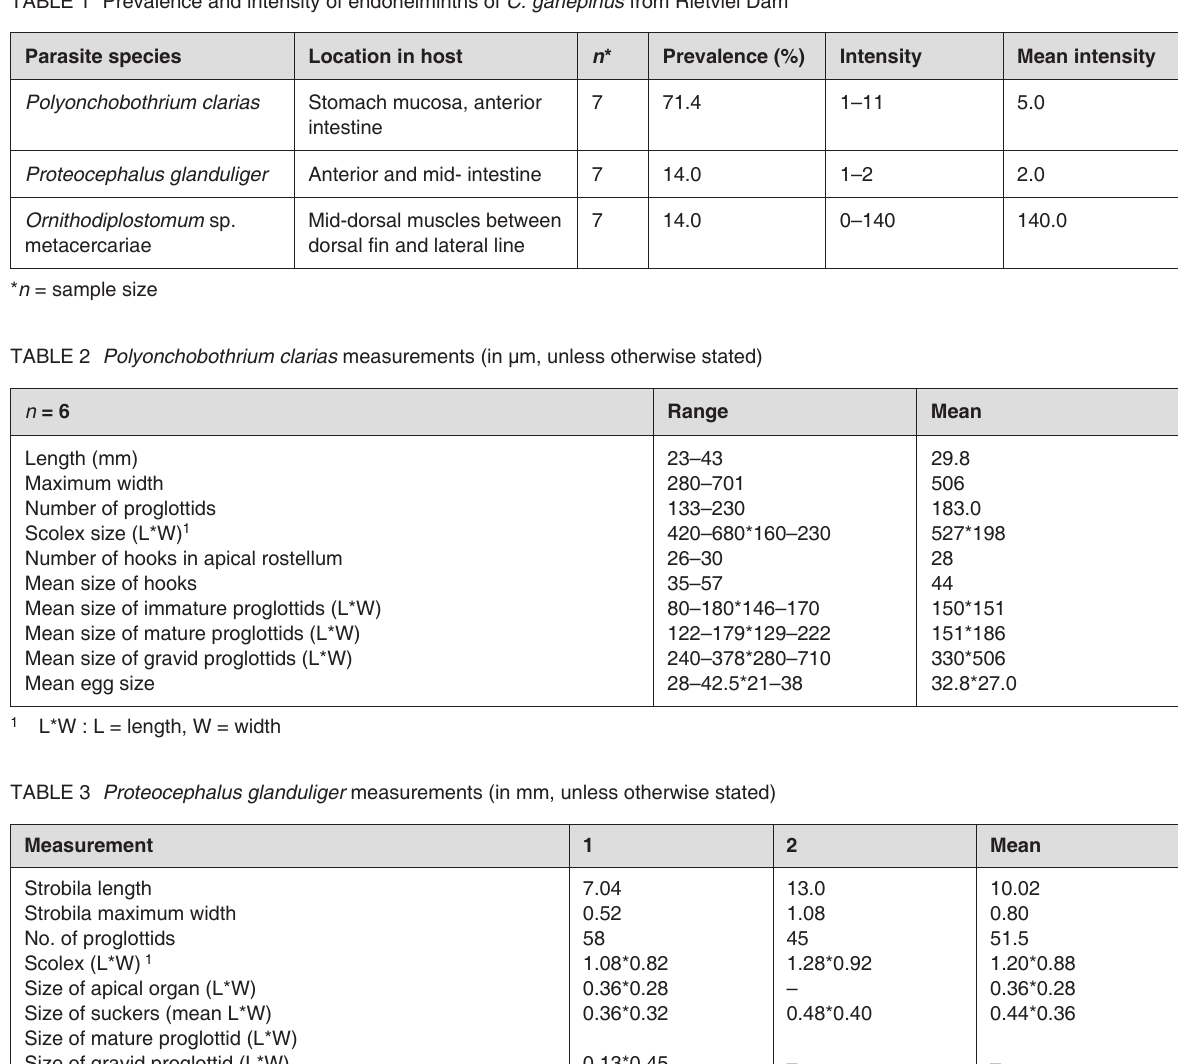
TABLE 1 Prevalence and intensity of endohelminths of C. gariepinus from Rietvlei Dam Parasite species Location in host